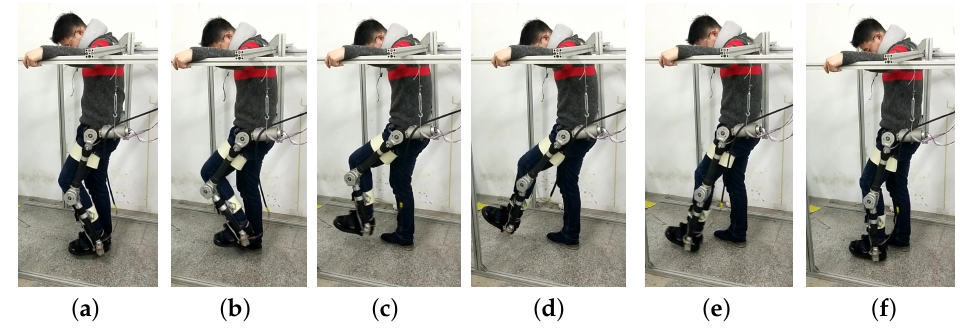
Figure 11. Experiment with the human subject (subject A) during the swing phase of normal locomotion. ( a ) Heel rise; ( b ) initial swing ; ( c ) middle swing; ( d ) terminal swing; ( e ) heel strike; ( f ) full ground contact. With the compliant interaction between the user and exoskeleton, the human subject was asked to sway his left leg naturally. The human intention is recognized by the deflection of the elastic modules mounted on both hip and knee